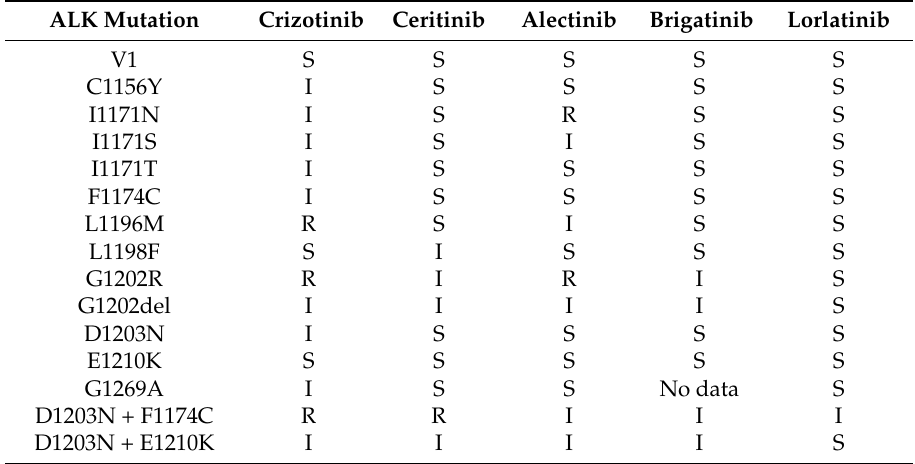
Table 4. Spectrum of activity of different Anaplastic Lymphoma Kinase (ALK) tyrosine kinase inhibitors for different resistance mutations, as studied by Gainor et al. using in vitro data on cell lines [84]. ALK Mutation Crizotinib Ceritinib Alectinib Brigatinib